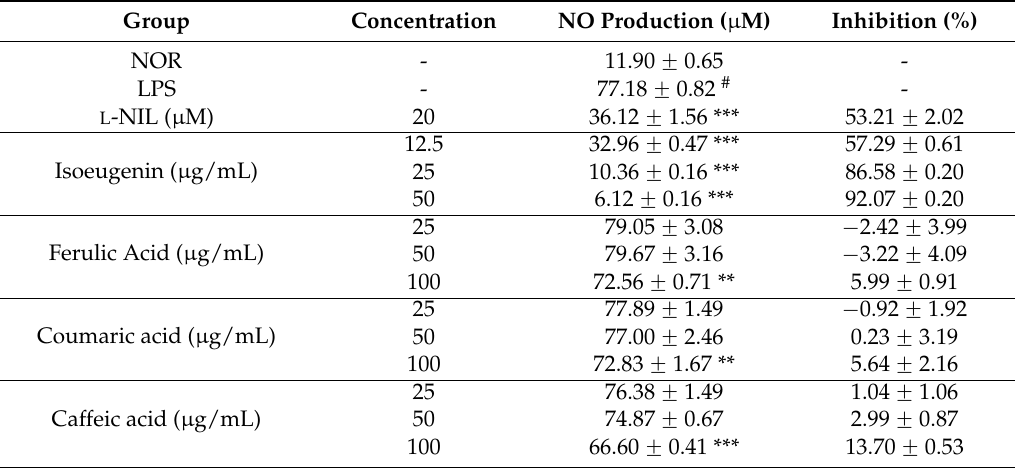
Table 3. Inhibitory effect of components of I. cylidrica on the LPS-induced NO production.